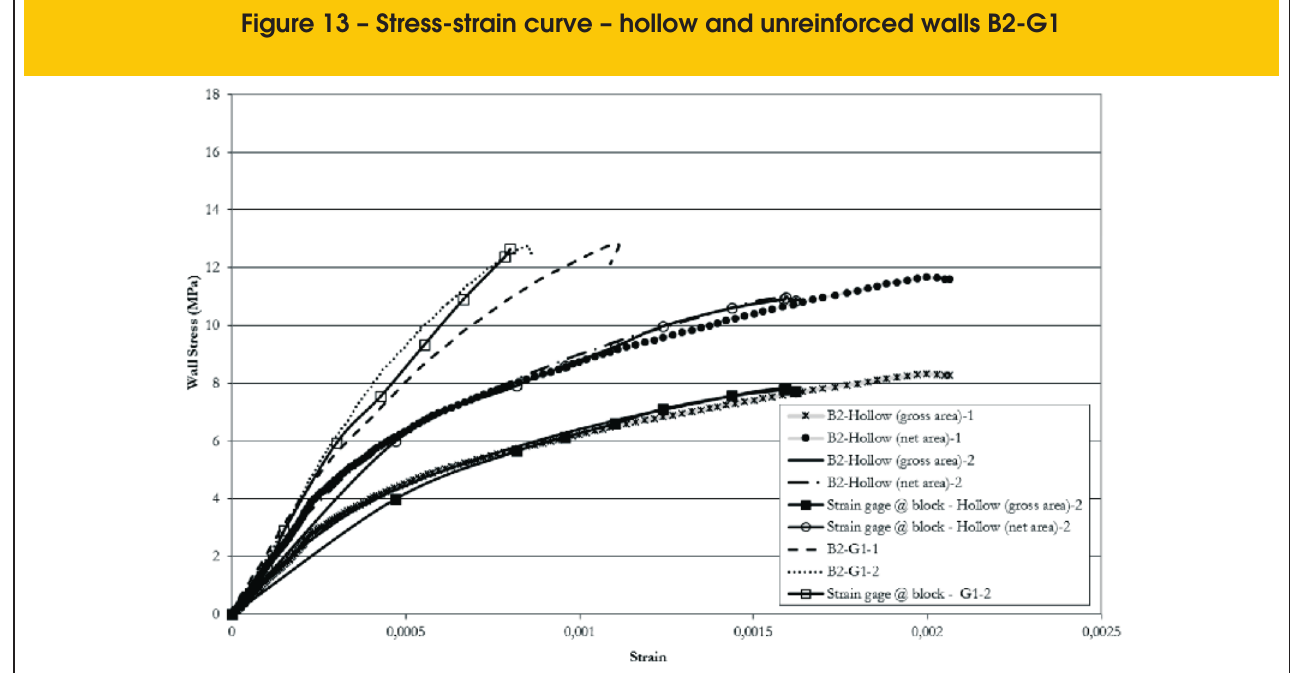
Figure 13 – Stress-strain curve – hollow and unreinforced walls